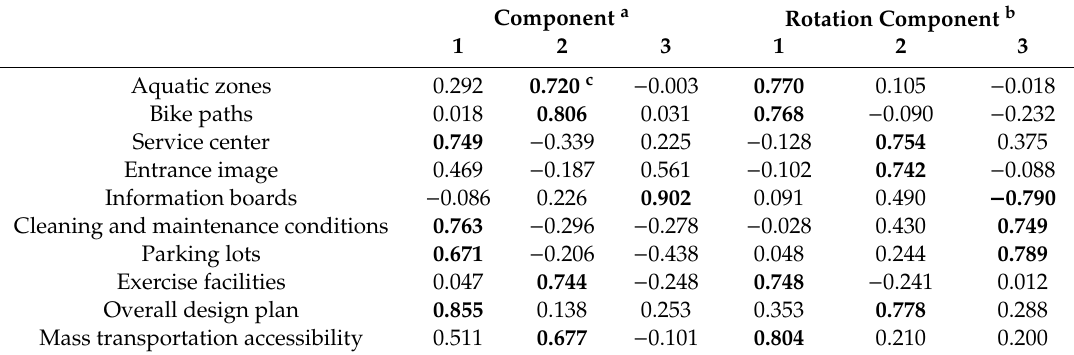
Table 7. Factor component loading